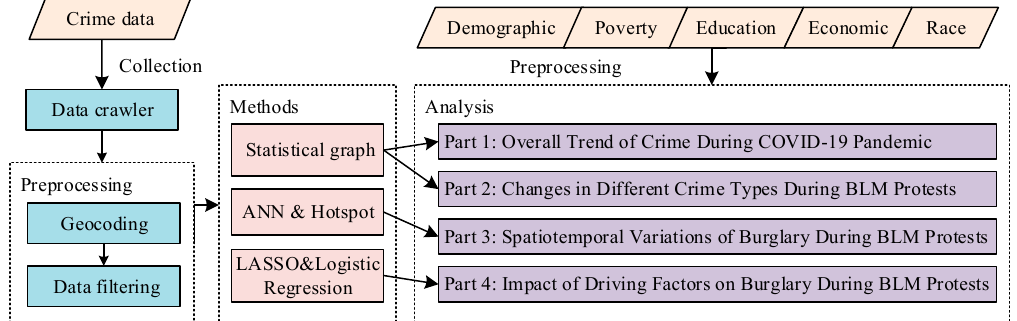
Figure 1. Workflow of the analytical process including datasets collected (yellow), data processing tools (blue), analyses methods (pink) and analytical results (purple).